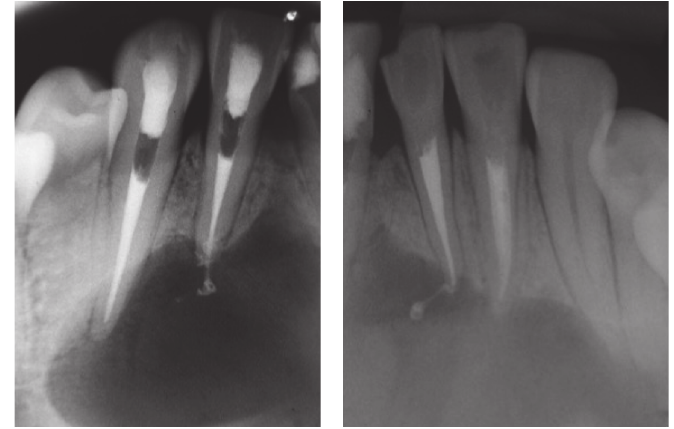
Figure 3: Periapical radiographs obtained immediately after obturation of root